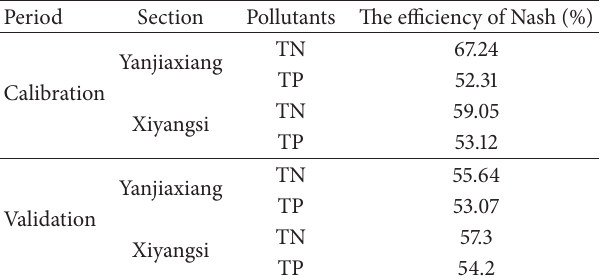
Table 3: The evaluation of calibration and validation of the model. Period